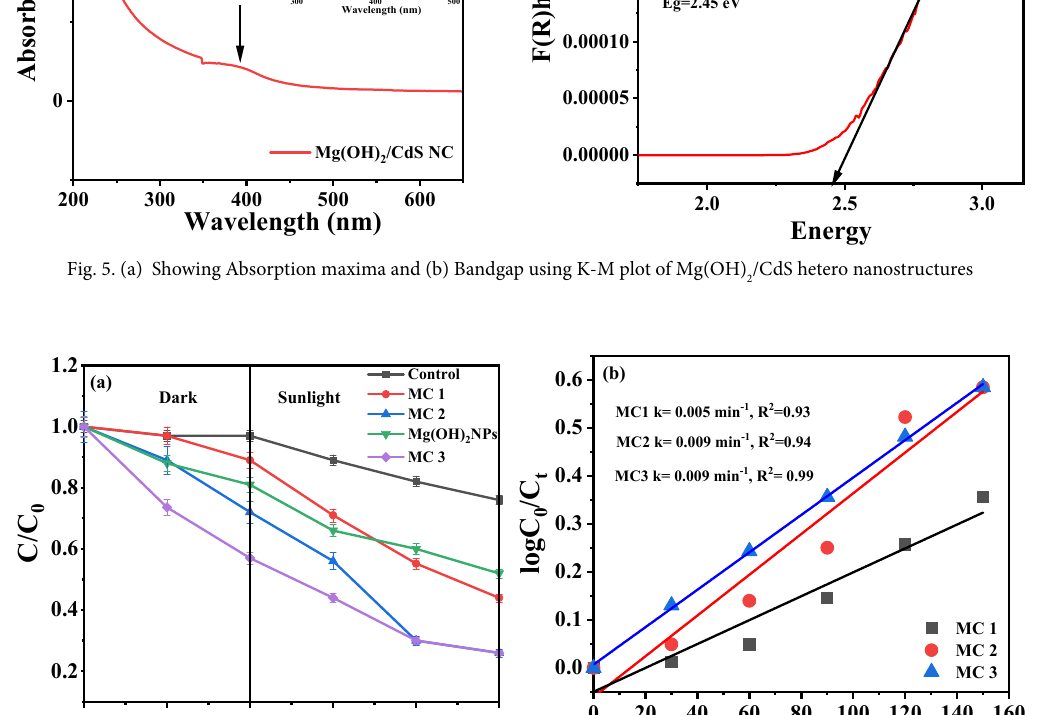
Fig. 6. (a) comparison of photocatalytic performance of both Pristine and Mg(OH) /CdS hetero nanostructures (b) plots of ln(Co/C) 2 versus irradiation time for various